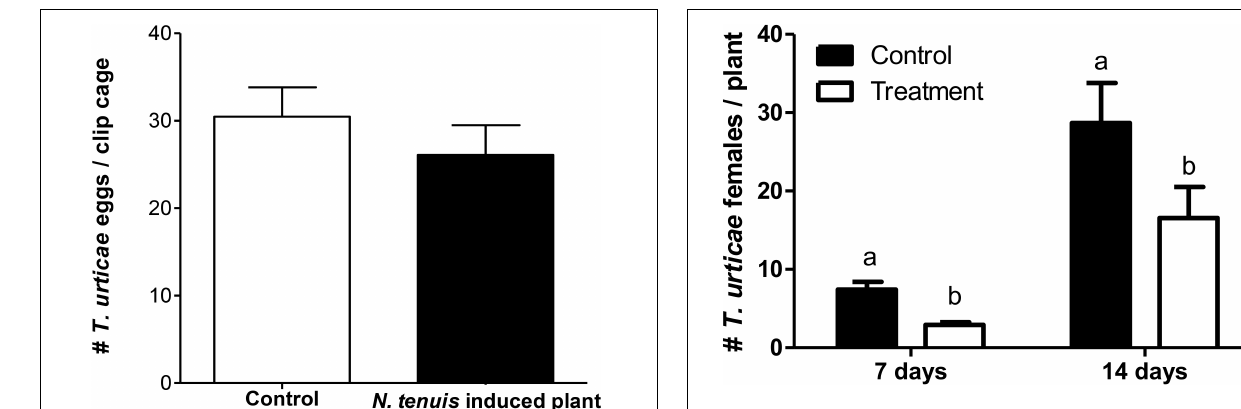
FIGURE 2 | Number of eggs (mean ± SE) laid by 10 T. urticae females in a clip cage in 48 h on N. tenuis -punctured tomato plants and on intact tomato plants at 25 ± 2 ◦ C and 14:10 h L:D.